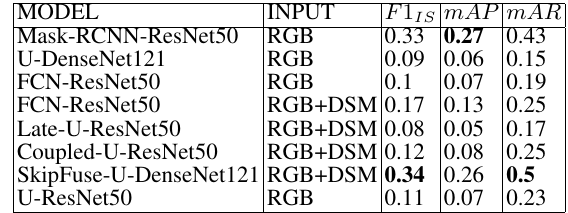
Table 1. Performance comparison of different models and input data for the building mask and touching borders classes. MODEL